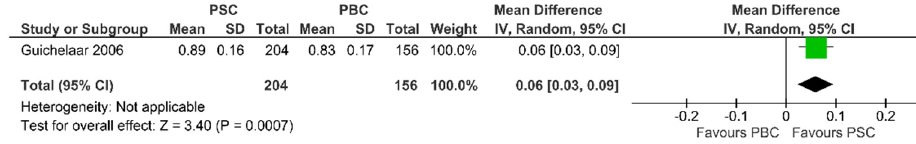
Figure 3. Forest plot assuming a random-effects model for BMD-LS PSC vs. PBC [30].